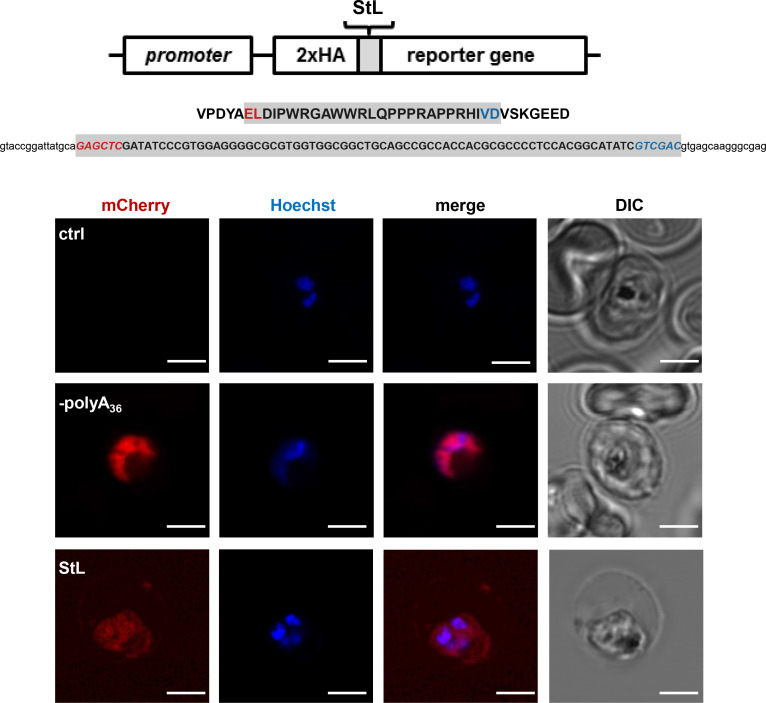
Schematic of stem-loop reporter construct (StL) used for expression in P. falciparum.Sequence of the inserted stem-loop is indicated. Below – live fluorescence microscopy of P. falciparum Dd2 parent (non-transfected) line as well as cells transfected with wild type (ctrl) or –polyA36 StL reporter constructs, 2.5 µm scale bar is shown.